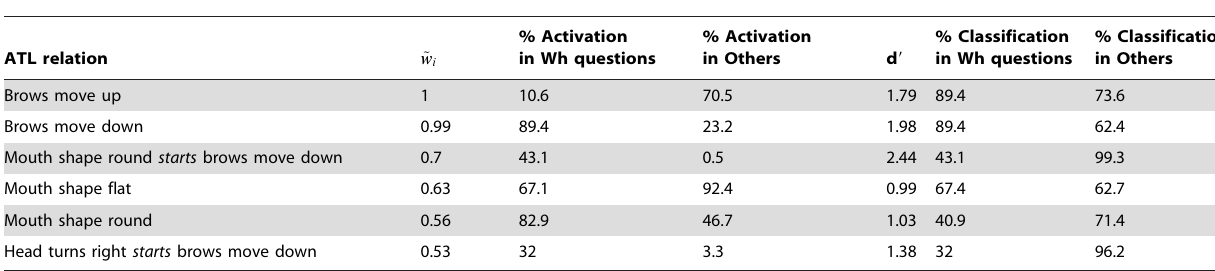
Table 4. Discriminant features for Wh-questions.